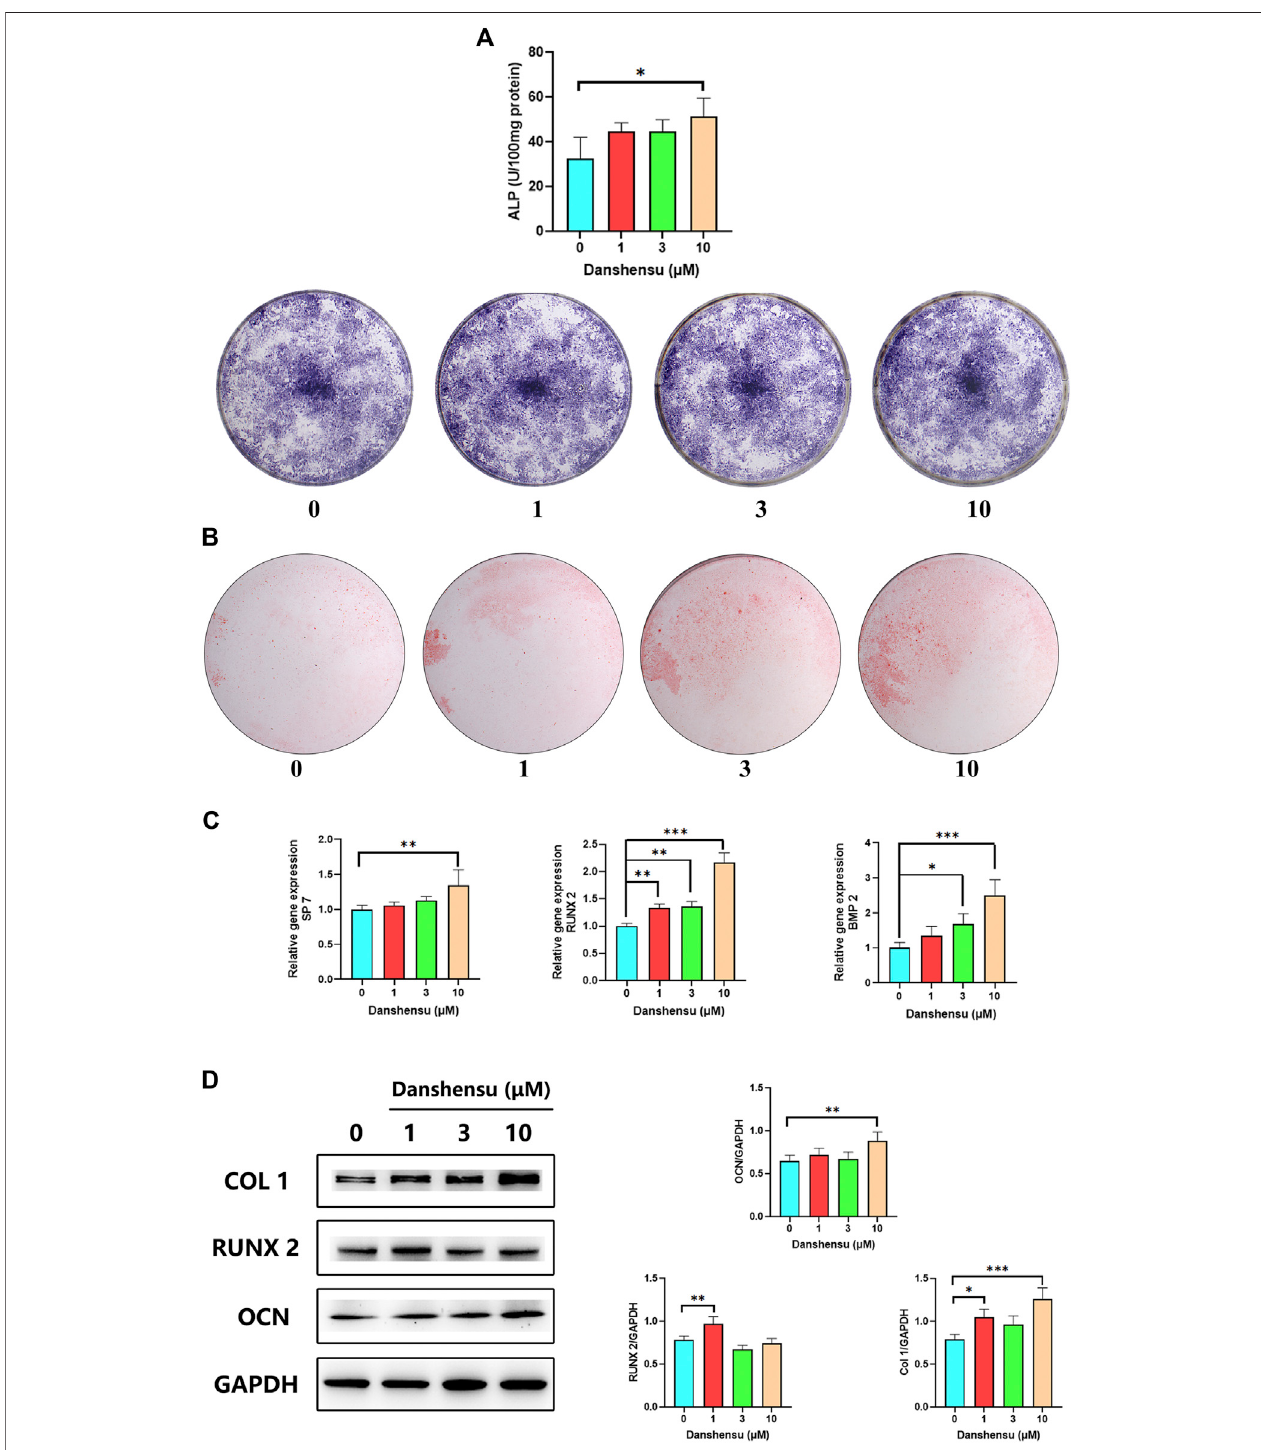
FIGURE 8 | Danshensu promotes ossi fi cation of normal osteoblasts. (A) ALP activity and staining of osteoblasts after 7 days of treatment with different concentrations of Danshensu. (B) ARS of osteoblasts on day 30. (C) SP7 , BMP2 , and RUNX2 mRNA expression in osteoblasts on days 14. (D) RUNX2 , COL1 , OCN , and GAPDH protein levels on days 14. * p < 0.05, ** p < 0.01, *** p < 0.001 vs. 0 group, n (cid:2) 3.